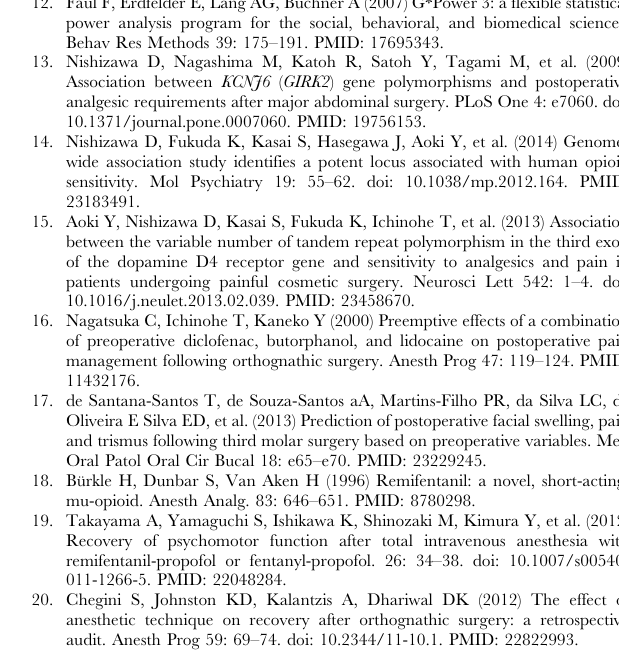
Table S1 Frequency of patients and VAS